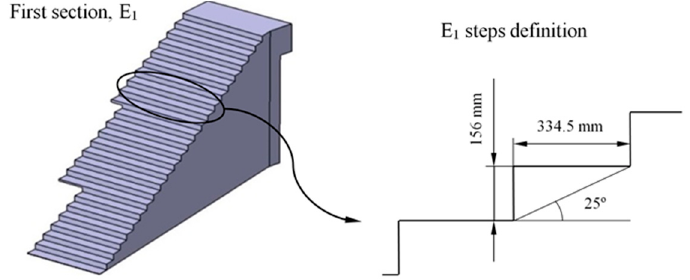
Figure 10. Definition of the steps for the first section of the E 1 construction element.